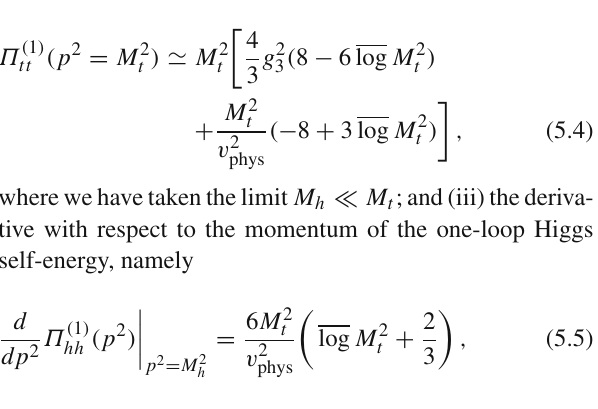
Fig. 3 Comparison of the dependence on the renormalisation scale Q of our Standard-Model results in the MS and OS schemes, at both one- and two-loop orders. Here the quantity Δλ SM is defined hhh − (λ ( 0 ) ) SM . The numerical inputs used for SM parameters as λ SM hhh hhh in this paper are as follows: for g 3 and v phys we use values from the ( Q = M ) = g 2 / 4 π = 0 . 1181 and PDG [125], respectively α MS Z √ S 3 = 1 . 1663787 · 10 − 5 GeV − 2 , while for the top quark G F = 1 / 2 v 2 phys pole mass we take M t = 173 . 5